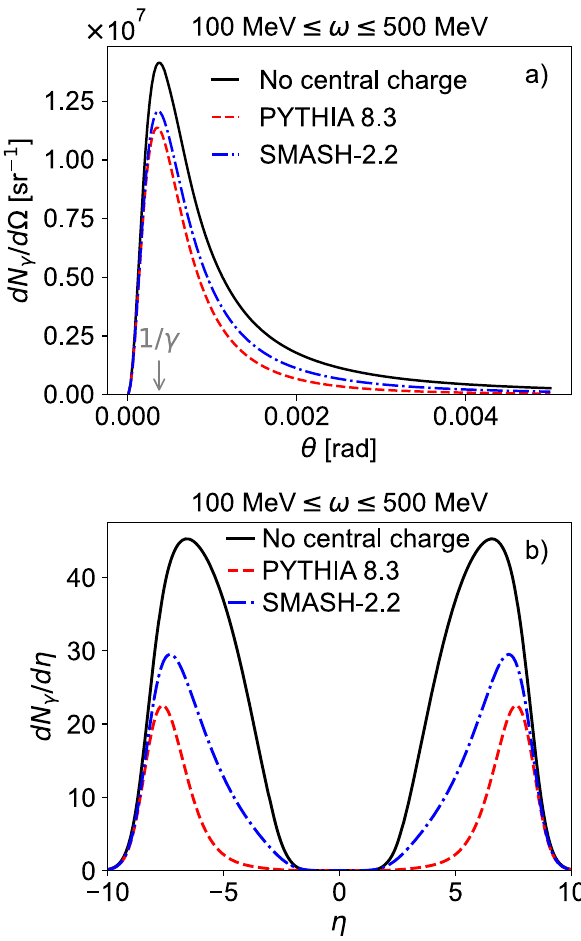
Fig. 2 a Theangulardistributionofbremsstrahlungphotonswithener- gies between 0 . 1 ≤ ω ≤ 0 . 5 GeV for the 3 scenarios. b The pseudo- rapidity distributions, dN γ / d η , of bremsstrahlung photons within the same energy range